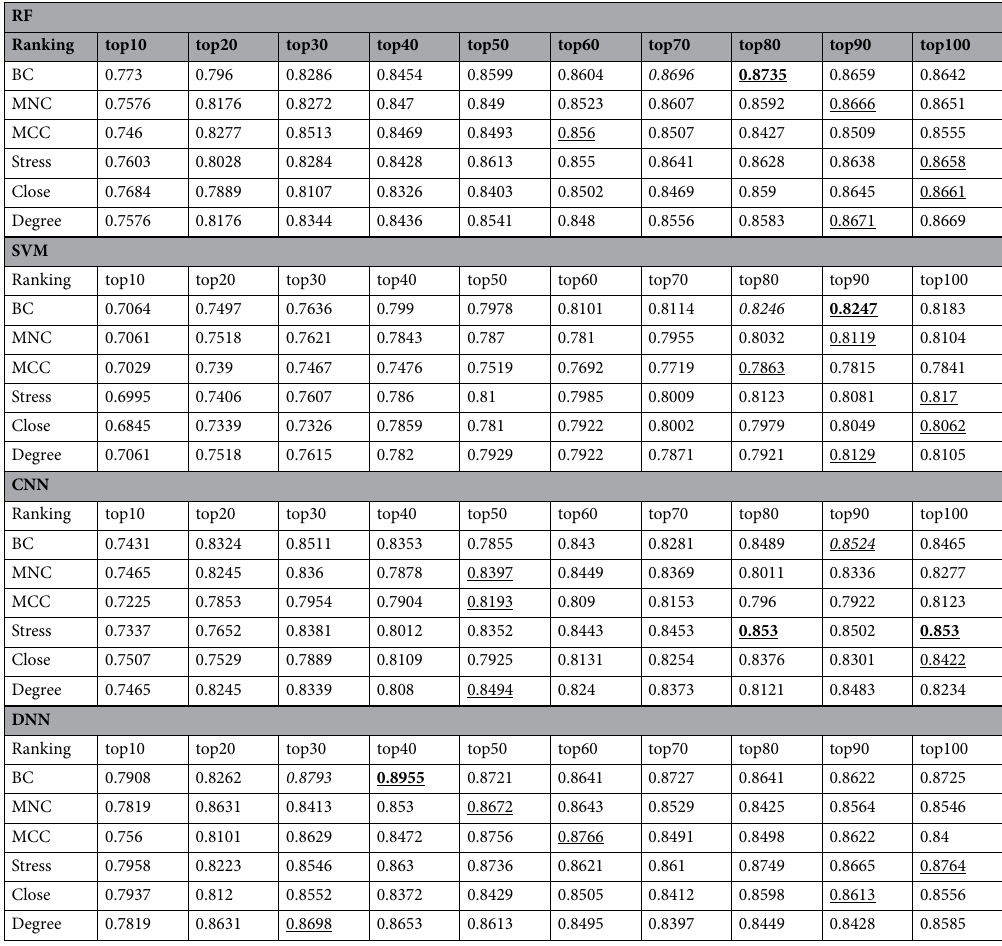
Table 3. Based on six topological ranking algorithms, the prediction performances for RF, SVM, CNN, and DNN in terms of AUC for top-ranked DEGs (increased by 10). The underline indicates the highest AUC achieved for each ranking algorithm. The Bold and Italic values suggest the best and second-best performing ranking